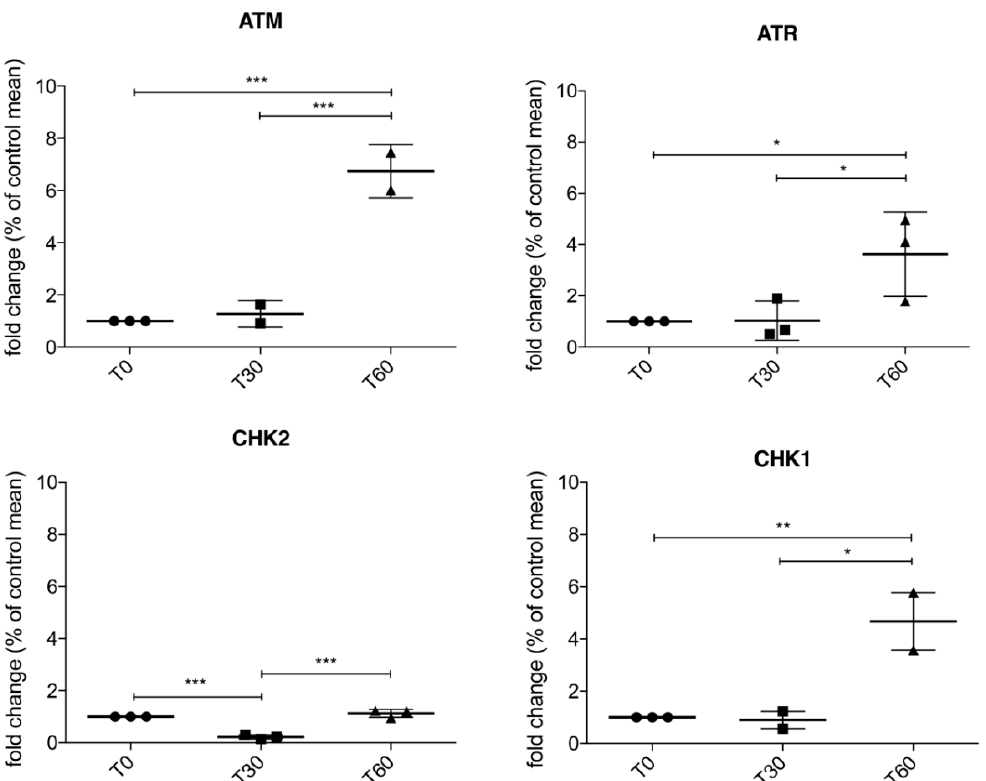
Figure 2. RT-qPCR in SH-SY5Y treated with 1 mM H 2 O 2 for 30 and 60 min showed that ATM / Chk2 and ATR / Chk1 are actively transcribed after 60 min of oxidative stress, suggesting that SOD1 localization in the nuclear compartment is involved in DNA damage response. Data were analyzed by ANOVA ( n = 3), followed by Newman-Keuls Multiple Comparison Test; * p < 0.05; ** p < 0.01 and *** p < 0.001.